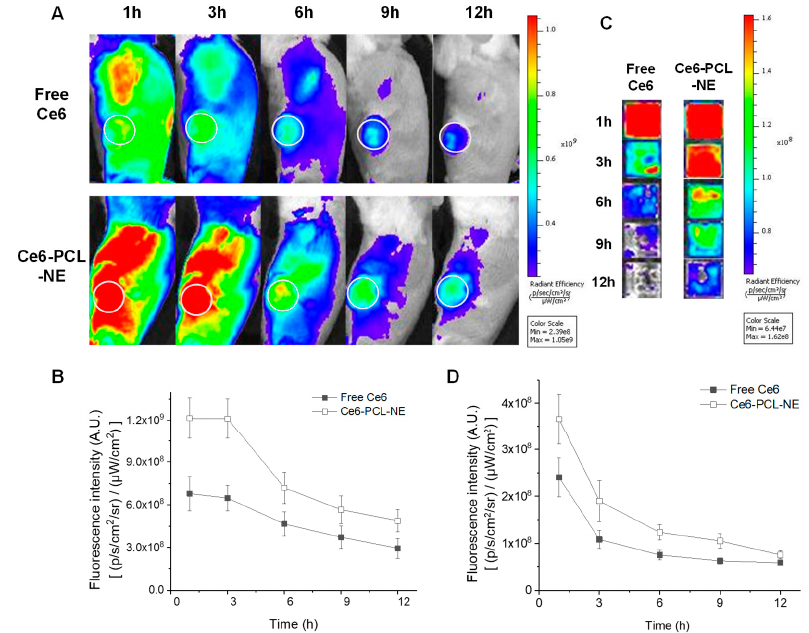
Figure 4. In vivo biodistribution of Ce6-PCL-NE in 4T1 tumor-bearing mice after intravenous injection. ( A ) Whole body NIR fluorescence images of 4T1 tumor-bearing mice after intravenous injection of free Ce6 and Ce6-PCL-NE. ( B ) Quantification of fluorescence intensity analysis at tumor site in ( A ) ( n = 3). ( C ) NIR fluorescence images of blood from mice in ( A ). ( D ) Quantification of blood fluorescence intensity in ( C ) ( n = 3).